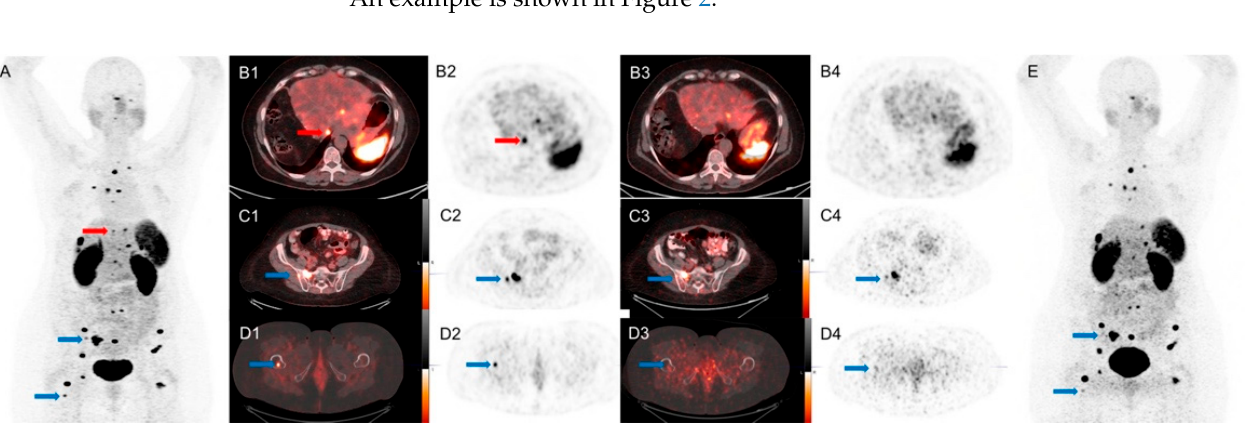
organs analyzed (except for other sites of lesions), but the difference was significant only for bone lesions.